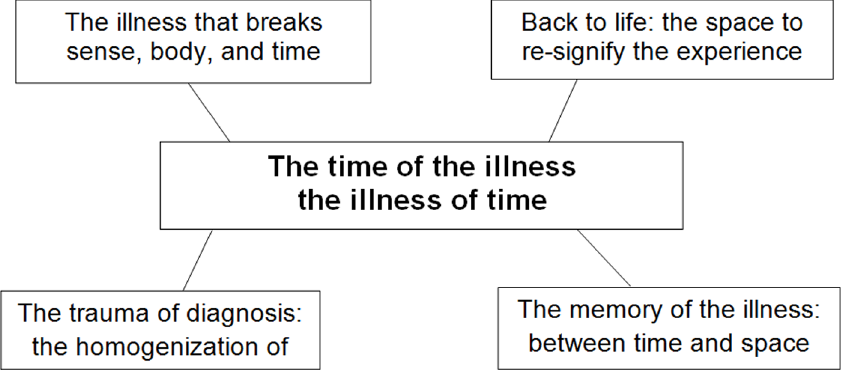
Figure 1. The time of illness, the illness of